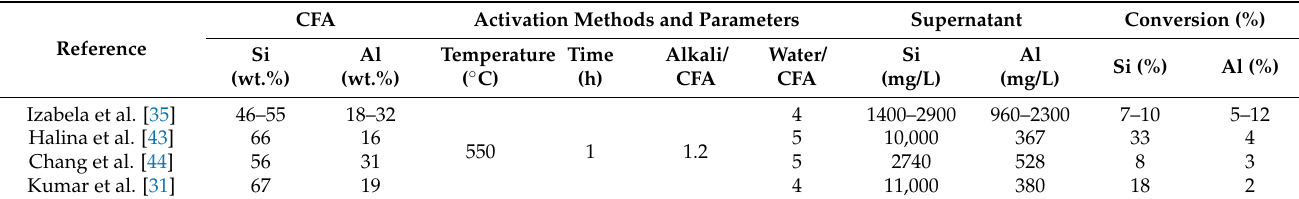
Table 4. Extraction effect of silica and alumina from CFA using alkaline fusion activation in various references. Activation Methods and Reference